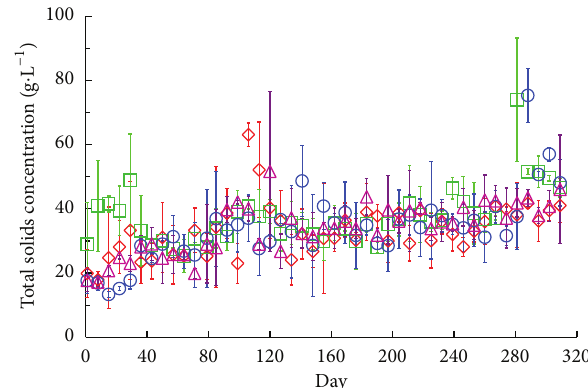
Figure 4: Total volatile fatty acid concentrations for all digester systems during the operation period; 𝑅 = ◻ ; 𝑅 = △ . 𝑅 mixer recycle